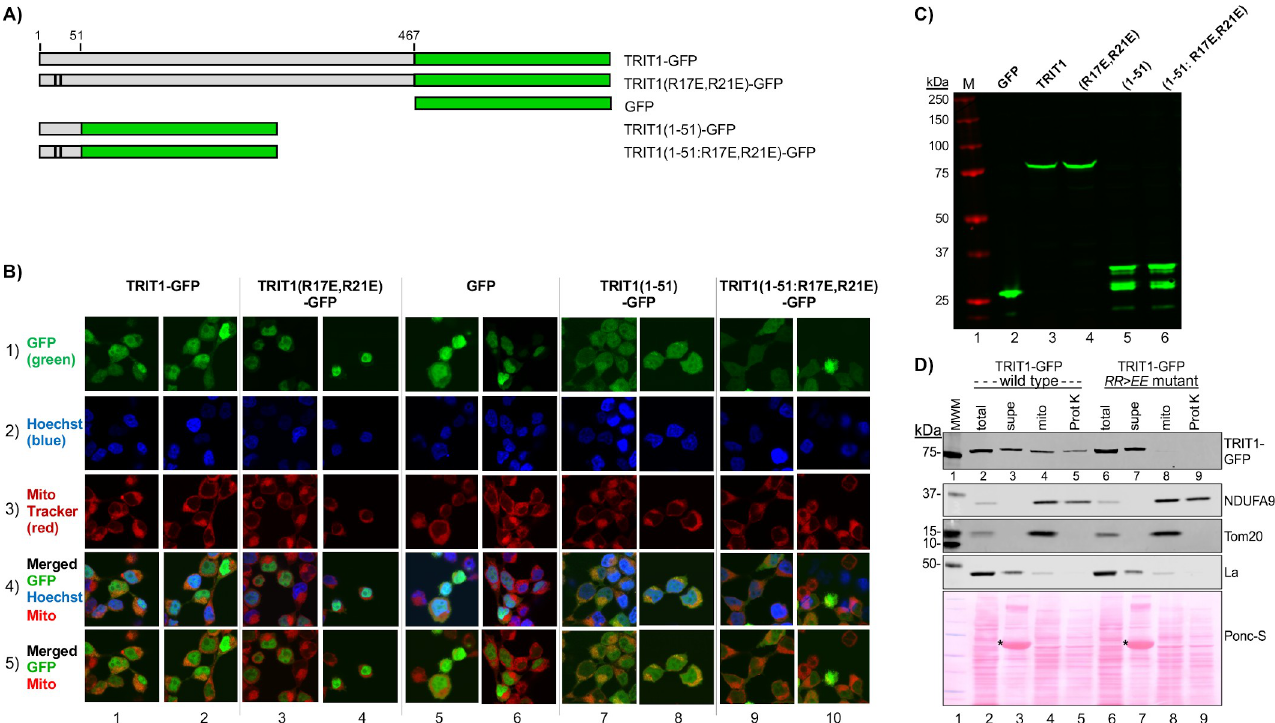
Fig 2. Human TRIT1 contains an N-terminal mitochondrial targeting sequence (MTS). A) Cartoon of the GFP-fusion constructs. Numbering represents amino acids of TRIT1; black vertical lines indicate positions of two mutated residues in the R17E/R21E constructs. B) Representative confocal microscopic images from HEK293 cells transfected 48 hours prior with the constructs in A and stained with Hoechst and MitoTracker. C) Western blot from cells transfected with constructs in A) using anti-GFP antibody (Ab). D) Western blot subcellular fractionation analysis. Transfected HEK293 cells were fractionated 48-hour later into supe (cytosol), mitochondria (mito) and mitochondria treated with Proteinase K (ProtK), the latter to digest proteins on the outer membrane of the mitochondria. GFP-TRIT1 WT and RR > EE mutant was detected using anti-GFP Ab. NDUFA9 is a mitochondrial inner membrane protein, La is a nuclear and cytosolic protein, TOMM20 is on the mitochondrial outer membrane. Total protein staining with Ponceau S is shown in the lower panel. Asterisks indicate BSA that was added during the mitochondrial isolation protocol (see text).